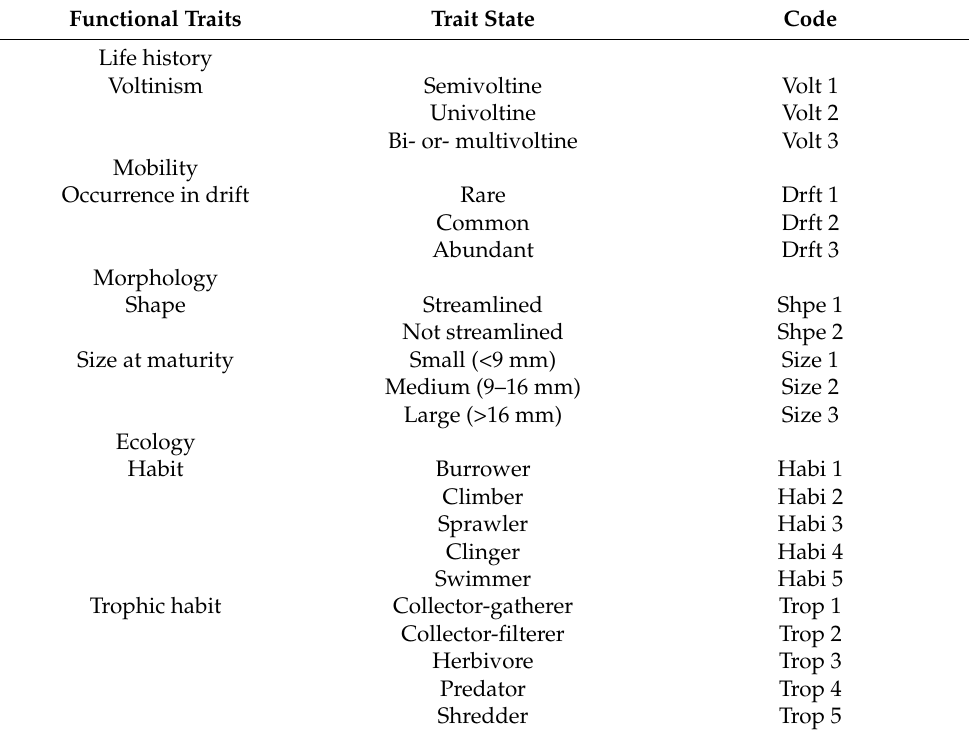
Table 1. The functional traits, trait state, and code of